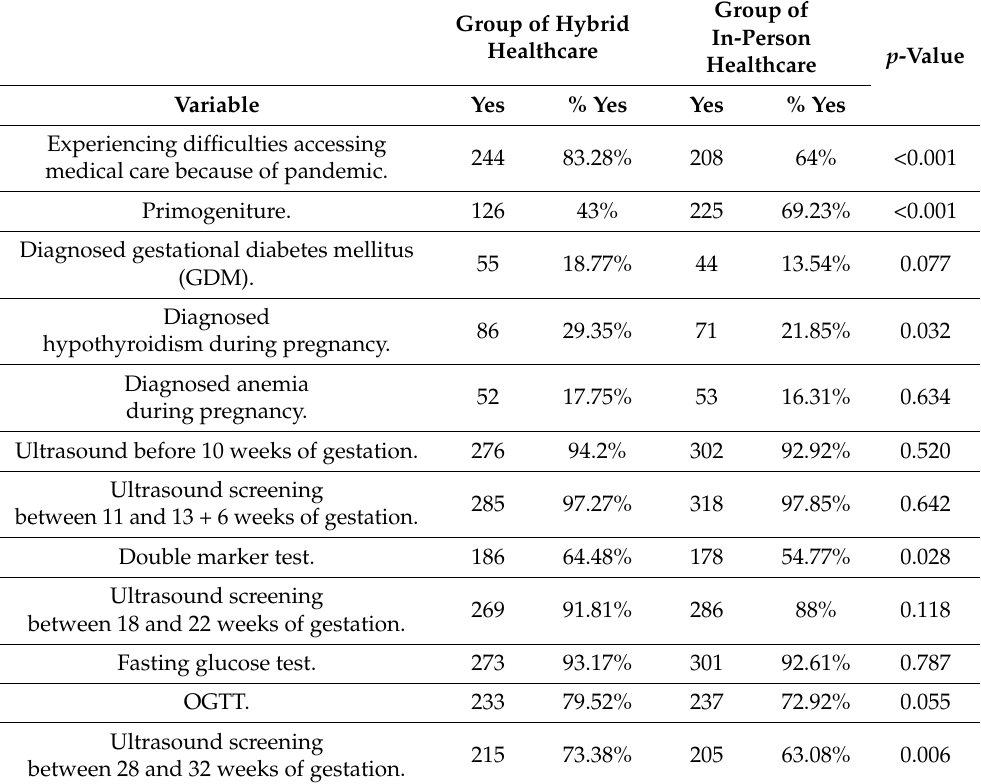
Table 2. Comparison of logical variables between in-person and hybrid healthcare groups.